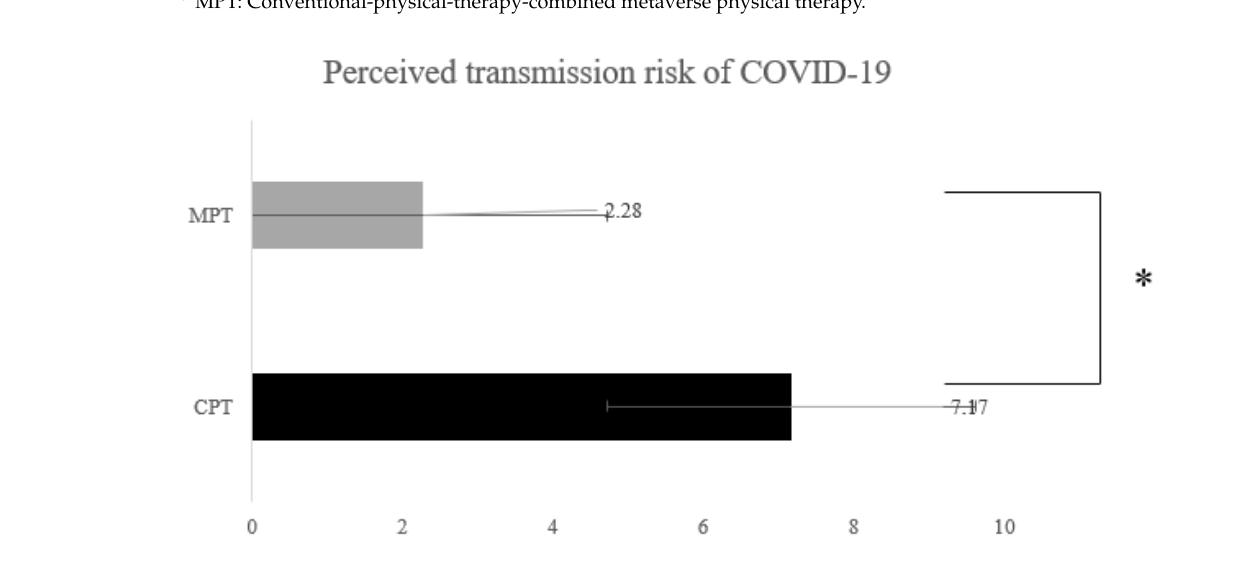
Figure 3. Perceived transmission risk of COVID-19. CPT: Conventional physical therapy. MPT: conventional-physical-therapy-combined metaverse physical therapy. COVD19; Corona virus disease 2019. * denotes p < 0.05